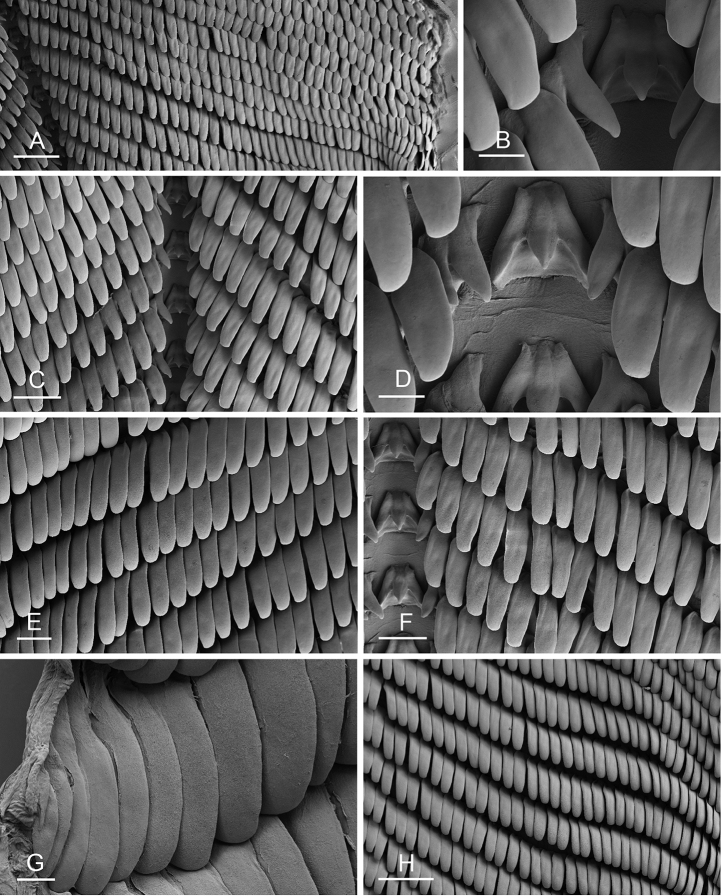
Radula, Peronia
setoensis, Japan, Honshu A–C holotype [5383 H] (NSMT-Mo 78985) D–F [3754] (NSMT-Mo 78987) G, H [3753] (NSMT-Mo 78987) A right half rows of teeth B rachidian and innermost lateral teeth C rachidian and lateral teeth D rachidian and innermost lateral teeth E lateral teeth F rachidian and lateral teeth G outermost lateral teeth H lateral teeth. Scale bars: 100 μm (A, H), 15 μm (B), 60 μm (C), 20 μm (D), 40 μm (E, F), 10 μm (G).